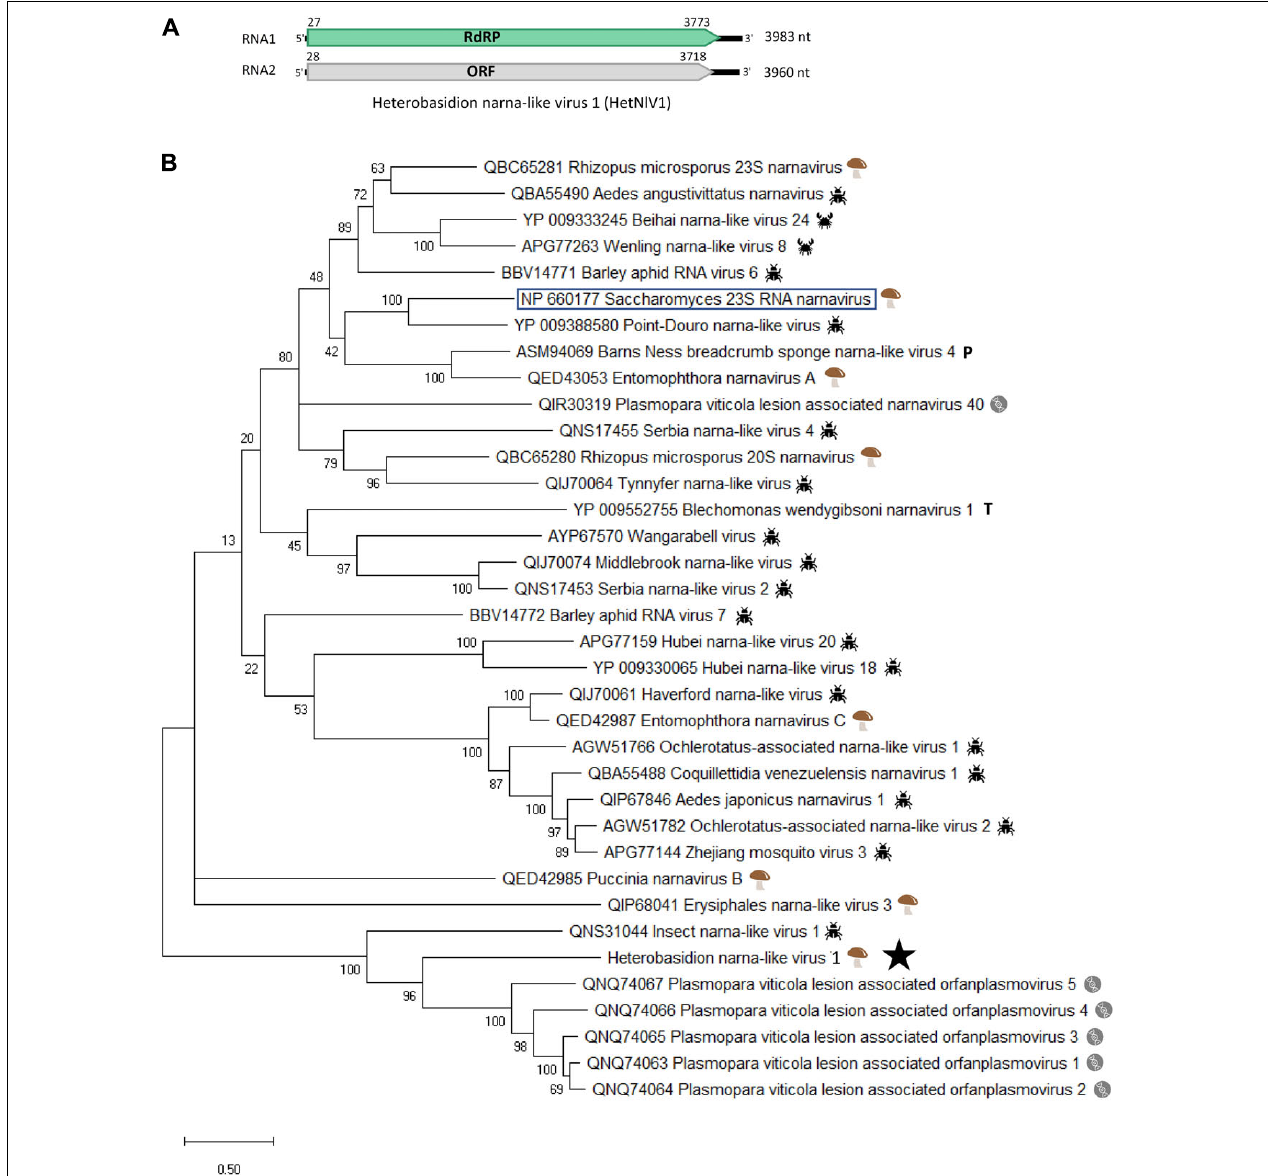
FIGURE 2 | Genome organization and phylogenetic analysis of Heterobasidion narna-like virus 1 (HetNlV1). (A) Schematic presentation of HetNlV1 genome with UTRs and predicted ORFs with translation initiation and termination sites. (B) Phylogenetic tree including HetNlV1 and similar viruses based on an alignment of aa sequences of the RdRP encoding ORF generated using MAFFT v7.450 with Blosum45 substitution matrix. The viruses were selected based on BlastX similarity for HetNlV1 and Saccharomyces 23S RNA narnavirus (shown boxed). Evolutionary analyses were conducted in MEGA X (Kumar et al., 2018) with 500 bootstrap repeats (the percentage of trees in which the associated taxa clustered together is shown next to the branches). The evolutionary history was inferred by using the Maximum Likelihood method and Le_Gascuel_2008 model (Le and Gascuel, 2008). A discrete Gamma distribution was used to model evolutionary rate differences among sites (four categories +G +I). A star denotes the virus strain from Heterobasidion parviporum . The other symbols indicate the hosts: = fungi; = insect; = crustacean; = porifera; = trypanosomatida; = metagenomic from Plasmopara viticola-caused leaf